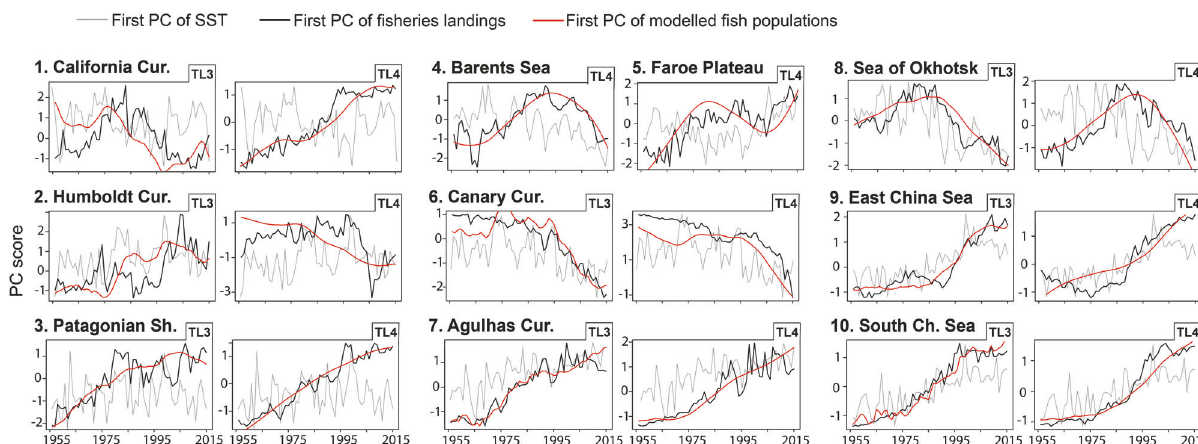
Fig. 3 Simulated marine fi sh dynamics matches independent empirical data from landings. Examples of covariance between simulated (red) and observed (black) fi sh populations in ten LMEs. Observed data is the fi rst principal component of the catch data within the LME, while modelled data is the fi rst principal component of simulated populations across all 1 × 1° grids within the LME (see Table S3 for variance explained per PC). Trophic levels 3 and 4 (TL3 & TL4) are both shown except for the Barents Sea and Faroe plateaus due to poor data availability. The thin grey line in each fi gure is the fi rst principal component of SST data in each LME. Numbers correspond to locations in Fig. 4a.